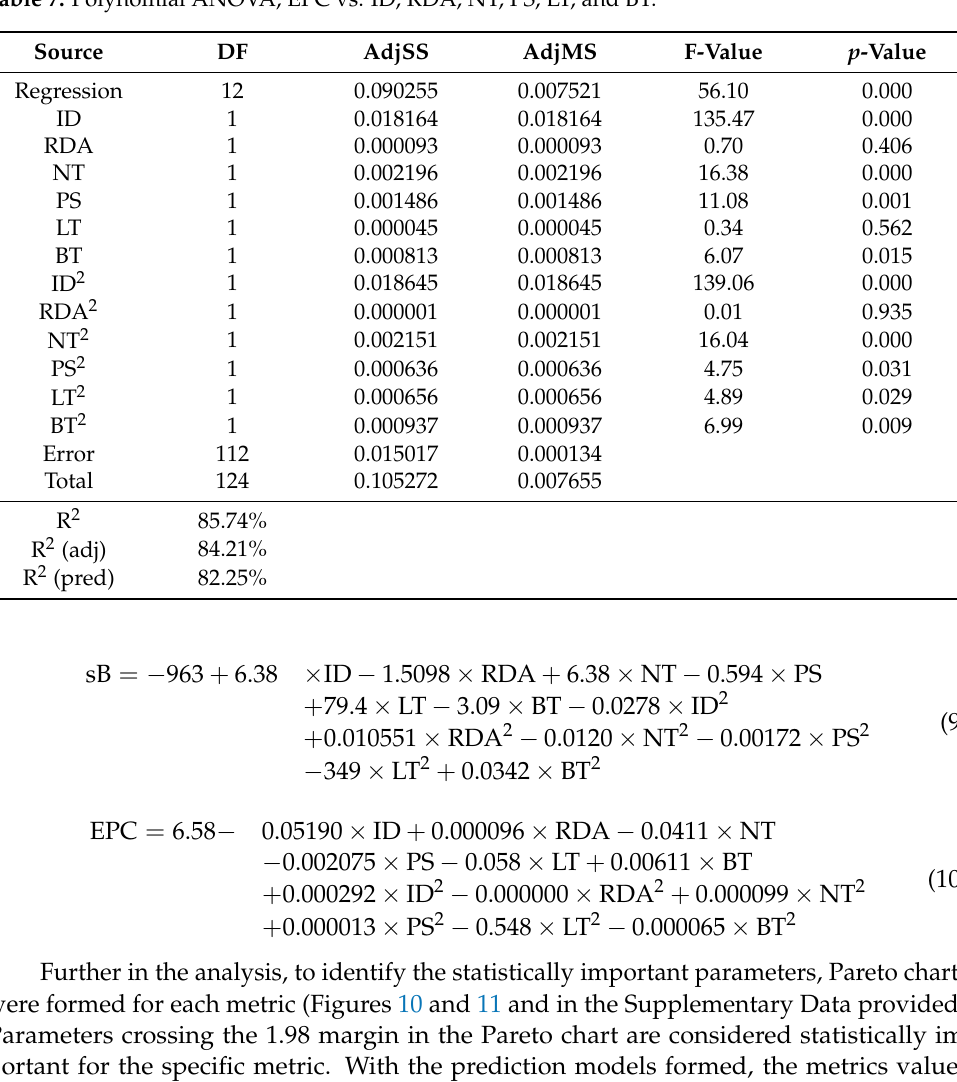
Table 7. Polynomial ANOVA, EPC vs. ID, RDA, NT, PS, LT, and